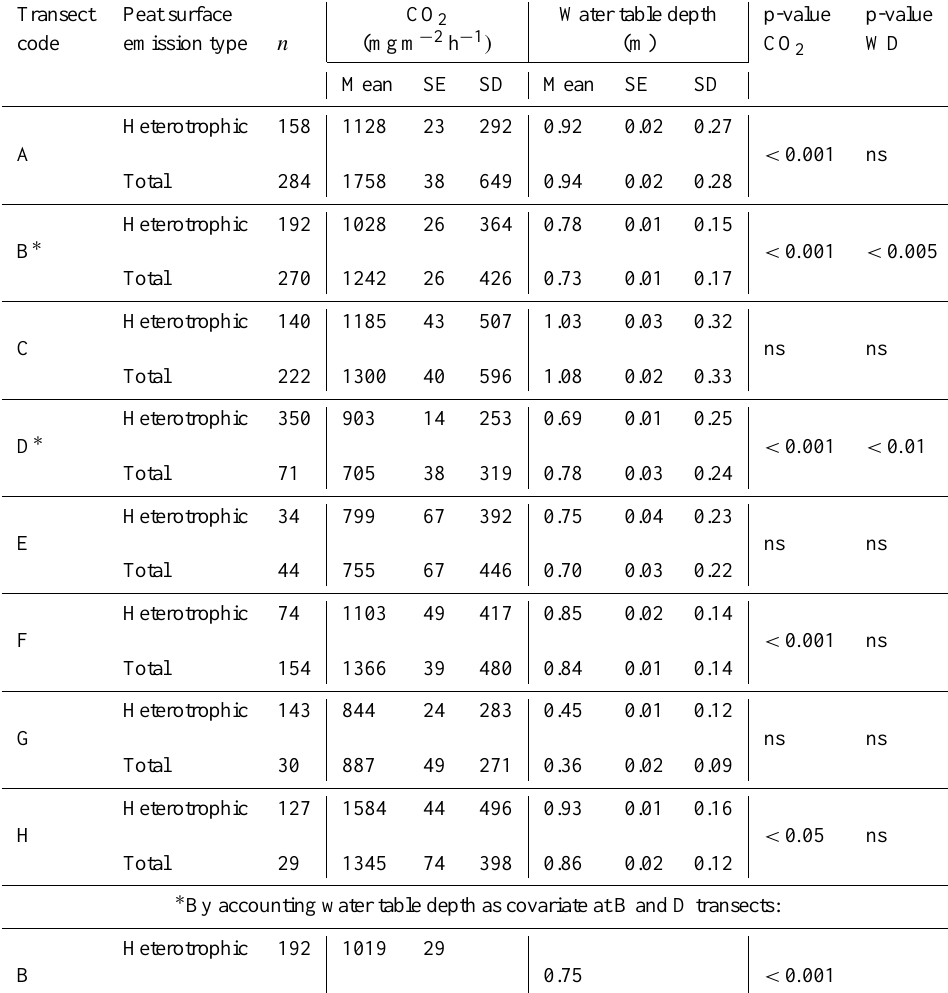
Table 4. Mean daytime measured heterotrophic respiration CO 2 emissions (in “furthest from trees” locations) and total soil CO 2 emissions (“nearest to trees” locations) and the related mean water table depths at the monitoring transects.